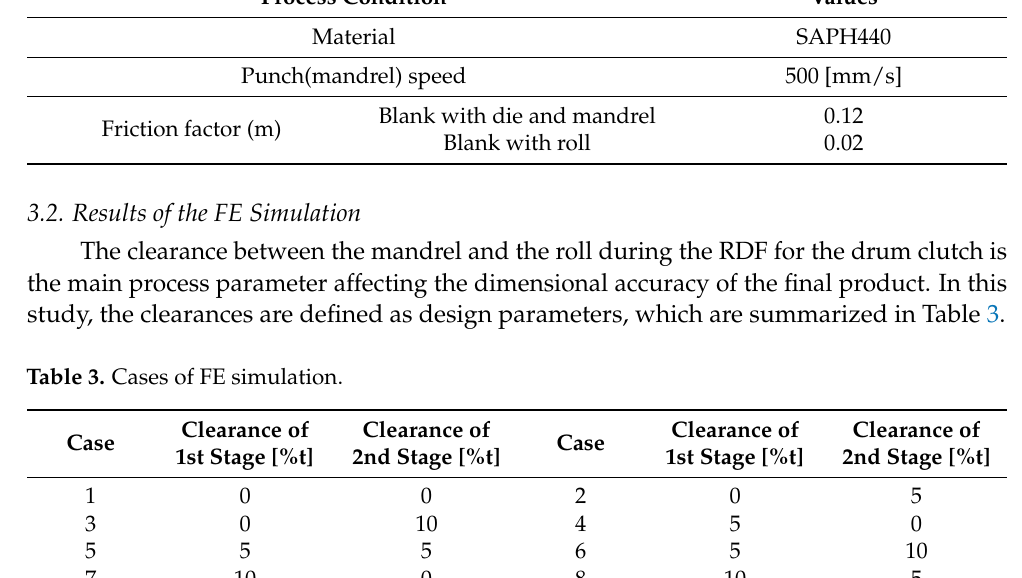
Table 3. Cases of FE simulation. Figure 5 shows the results of the FE simulation of the dimensional accuracy with various clearances. The predicted unfilled or overfilled area ranged from 0.1419 mm 2 to 0.2384 mm 2 for each tooth. In the case of zero clearance, an unfilling phenomenon occurred, whereas an over-filling phenomenon was observed in the case of 10%t clearance. Figure 6 shows the deformed shape and distribution of the effective strain for case 5. The effective strain largely increases during the 1st and the 2nd step of each stage because the inner and outer teeth are almost deformed in these steps. In the 3rd step, which is used for a sizing process, the effective strain is similar to the 2nd step because amount of deformation is small. A large distribution of the effective strain is also observed for the inner teeth owing to a relatively small clearance and large deformation. This may result in an increase in the level of wear on the punch and roll dies during mass production [15].